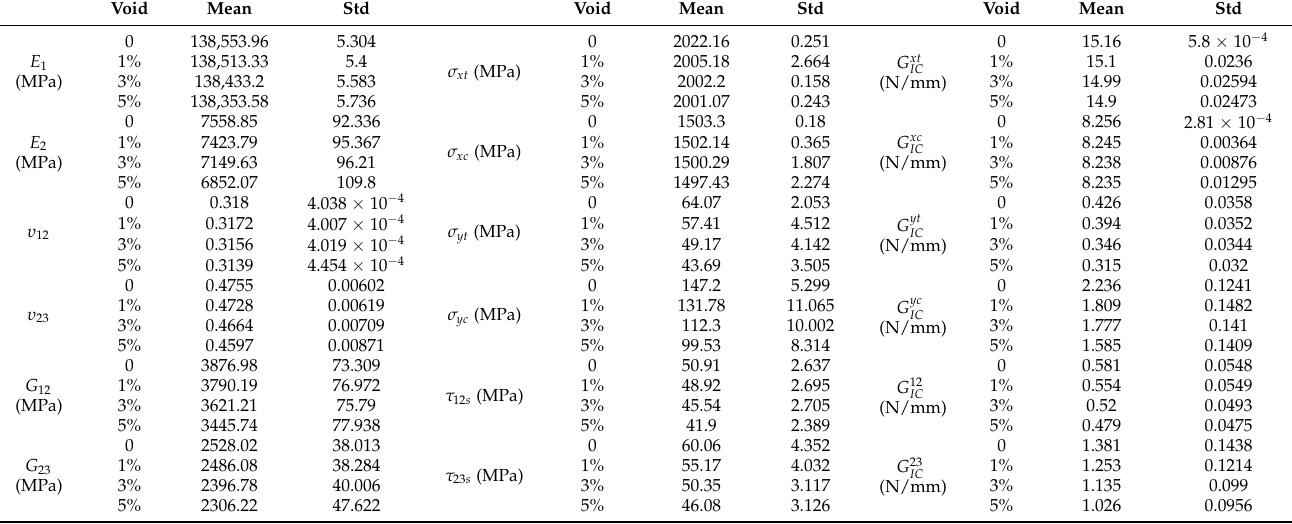
Table A1. Mean value and standard deviation of all mechanical properties for micro-scale